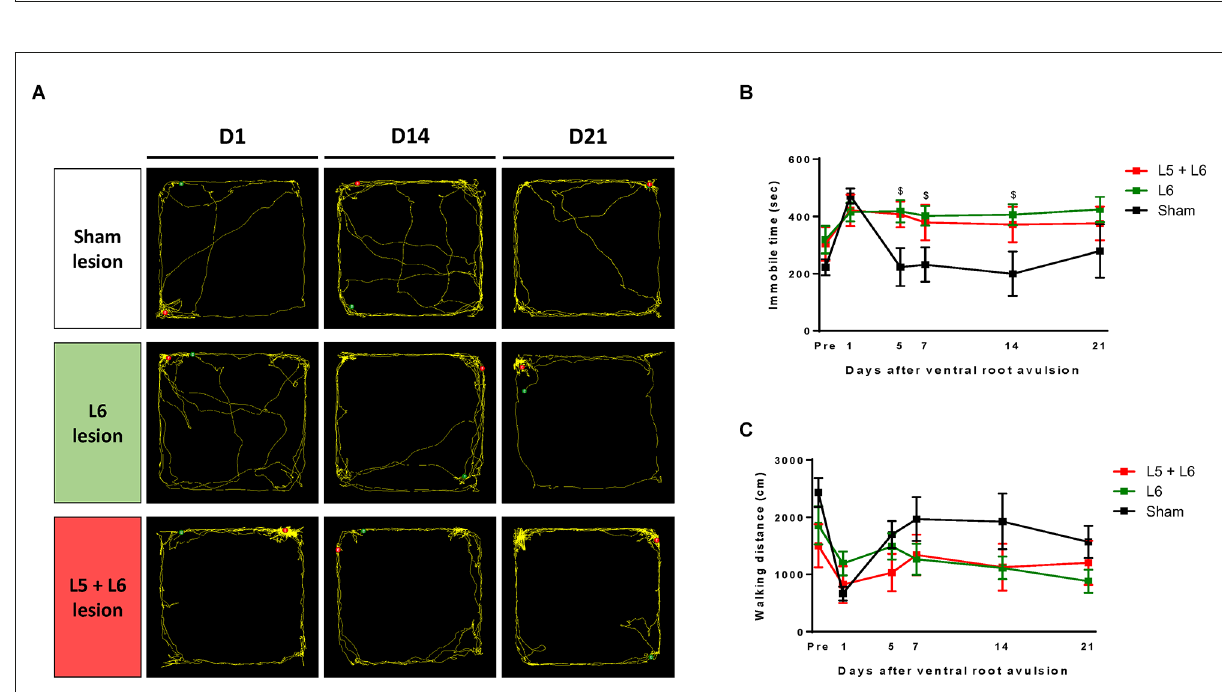
FIGURE6 The effect of ventral root avulsion lesions in the time-course analysis of the locomotor activity of rats with an open field test. A representative trajectory plot of rats 1, 14, and 21 days after ventral root injury surgery (A) . Time-course change among groups in immobile time (B) and walking distance (C) . Values are expressed as the mean ± SEM. $ p < 0.05, a significant difference between the L6 and sham